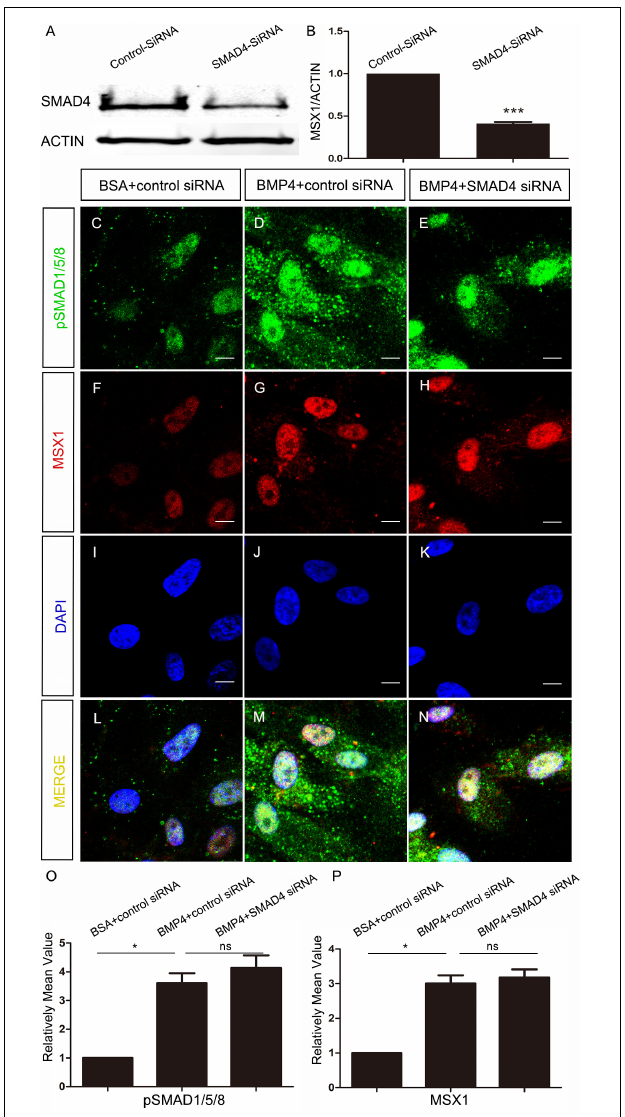
FIGURE 3 | SMAD4 is not required for BMP4-induced pSMAD1/5/8 nuclear translocation and MSX1 expression in the hDMCs. (A,B) Western blot shows approximately 60% knockdown efficiency of SMAD4 siRNA. (C–N) Co-immunostaining of MSX1 and pSMAD1/5/8 show that BMP4-induced pSMAD1/5/8 nuclear translocation and MSX1 expression are not affected by knockdown of SMAD4. (O,P) Quantitative analysis of relative mean fluorescence values shows that pSMAD1/5/8 and MSX1 expressions are not affected by the knockdown of SMAD4. Error bars represent SD. ns, p > 0.05; * p < 0.05; and *** p < 0.001. Bar = 10 µ